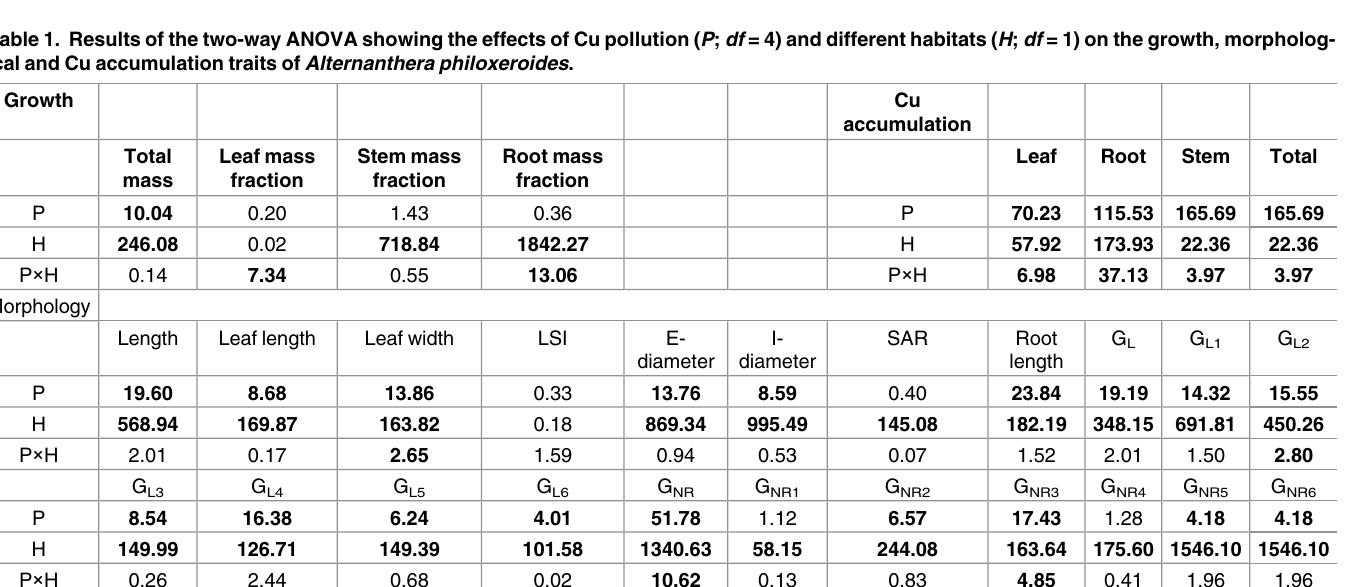
Morphology abbreviations are described in the experiment and measurements section of the Materials and Methods. F values are indicated, and the bold values indicate P < 0.05. Data were natural logarithm transformed prior to the